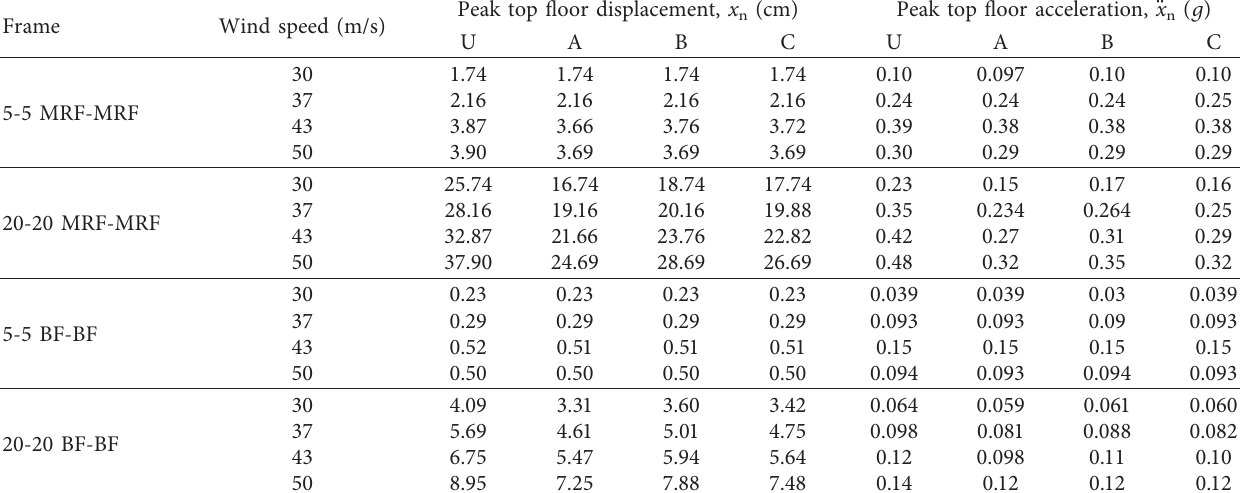
Table 7: Peak top floor displacement and acceleration responses of similar connected buildings for equal storey height under simulated wind forces for different gust speeds.